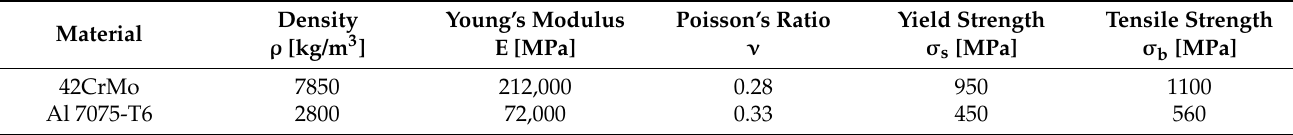
Table 4. Main properties of steel and aluminum used in the cylinder block.